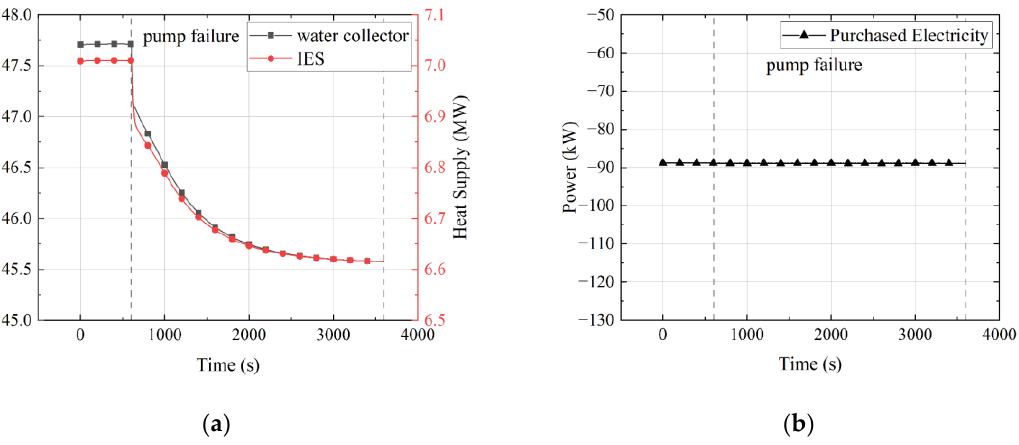
Figure 7. Response of the IES during pump failure period. ( a ) heat subnet; ( b ) power subnet.